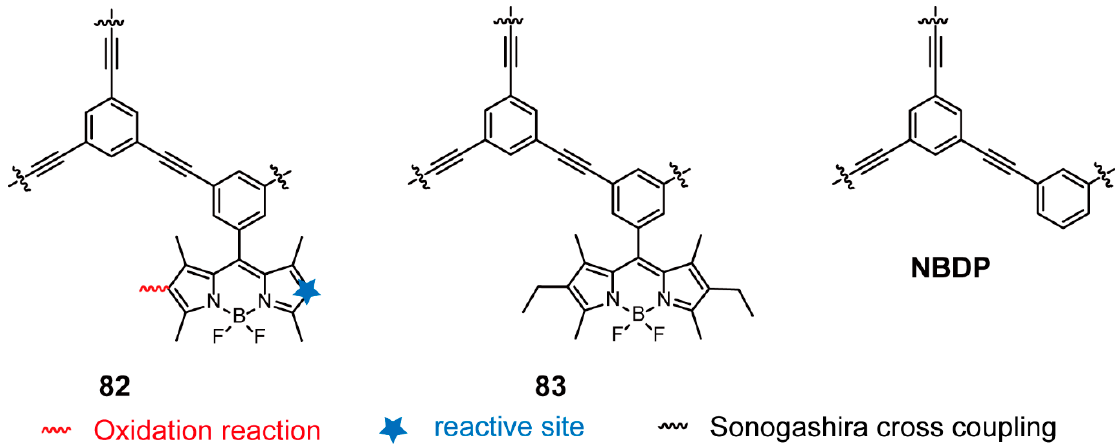
Figure 29. Chemical structures of polymers 82 , 83 , and NBDP (Reproduced with permission from Reference [107]. Copyright @ 2017, Royal Society of Chemistry).